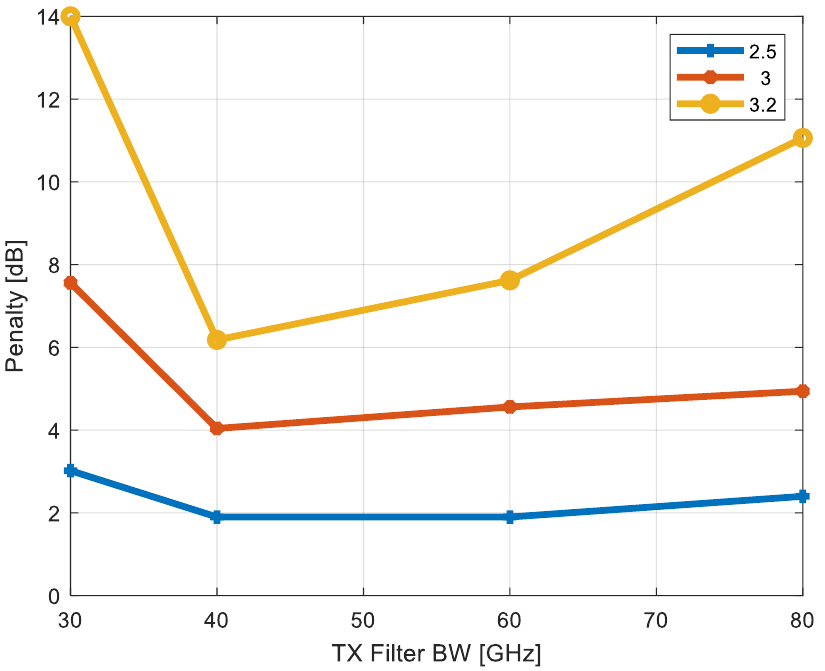
Figure 13. Penalty vs. transmitter filter BW (3 dB) of PAM-4 with filter orders of 3 at different fiber lengths ((km) in legend).